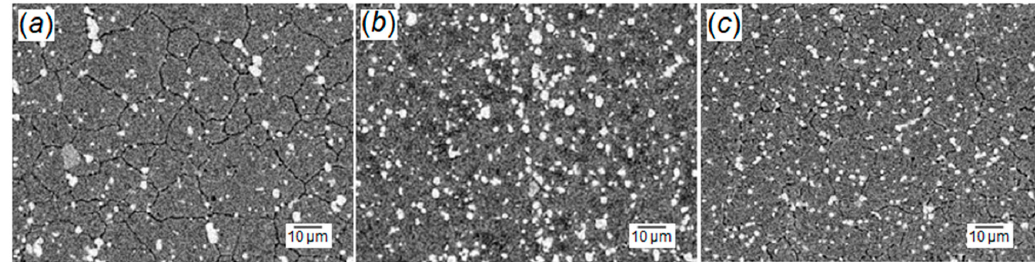
Figure 10. SEM image used for quantitative determination of the size and volume fraction of